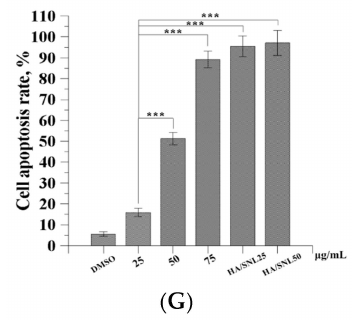
Figure 9. JC-1 staining-based apoptosis profile of A549 cells after a 24-h SNL and HA/SNL aggregates